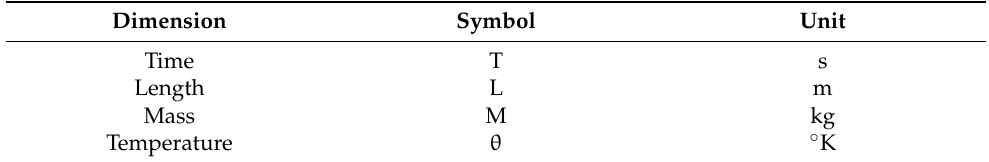
Table 3. Symbol and unit of the fundamental dimensions involved in the dimensional analysis. Dimension Symbol